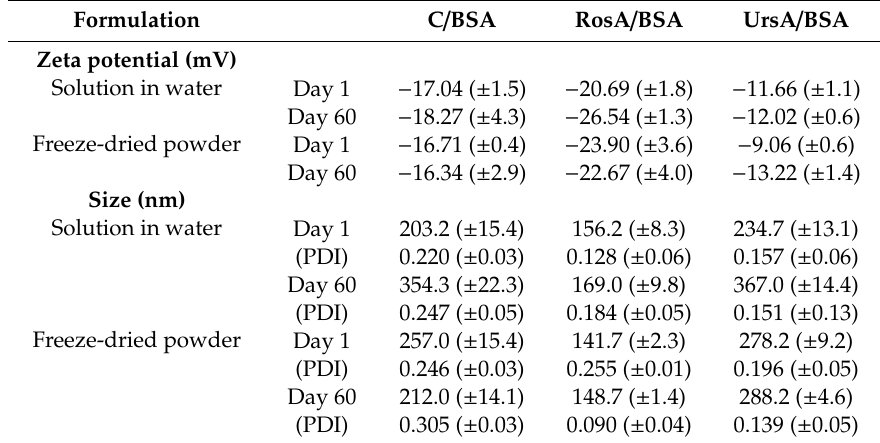
Table 1. Particle size and zeta potential measurements of bovine serum albumin (BSA) particle formulations containing curcumin, rosmarinic acid (RosA), or ursolic acid.